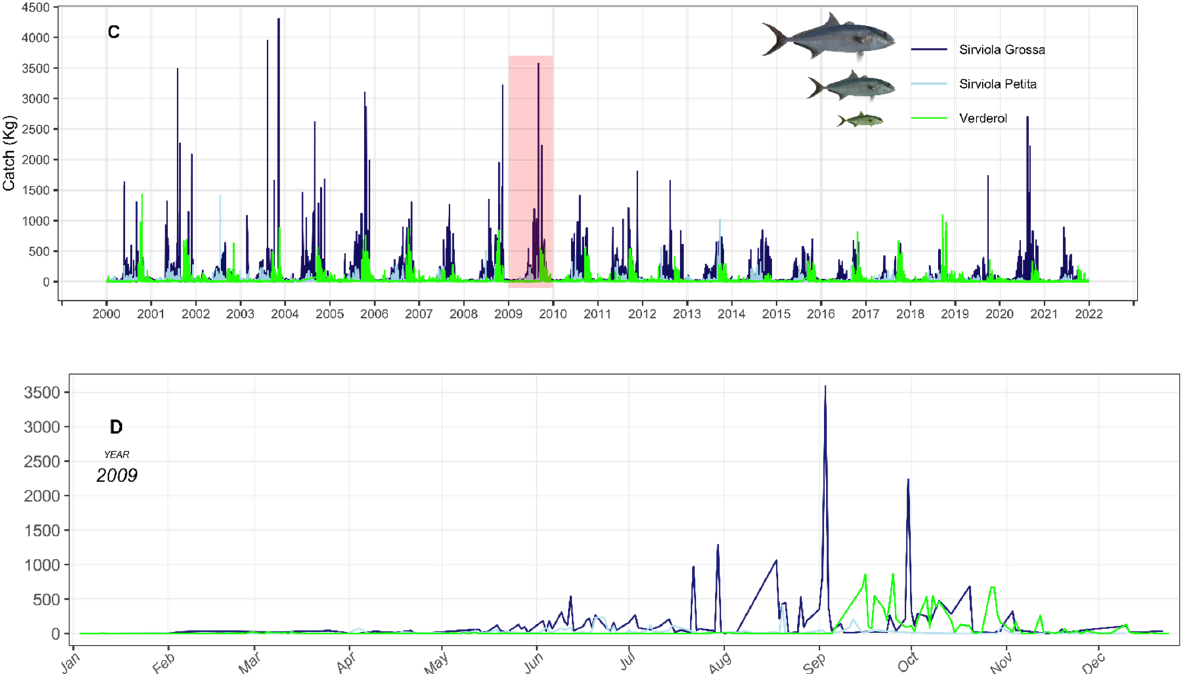
Figure 1. Socio-ecological data supporting the potential SES around S. dumerili fishery. ( A ) Economic importance of the main Balearic species as a function of price market value ( € /Kg). Pie-chart represents the % of total price for each species as an illustration of economic importance. Graph from the Ministry of the Environment, Agriculture and Fisheries of the Government of the Balearic Islands, using the fishery statistics for 2015. Total daily catches of S. dumerili ( B ) and by size classes ( C ) Sirviola Grossa (navy blue), Sirviola Petita (light blue), Verderol (green) from the period 2000 to 2021. Monthly catch distribution from the year 2009 is represented in ( D ).